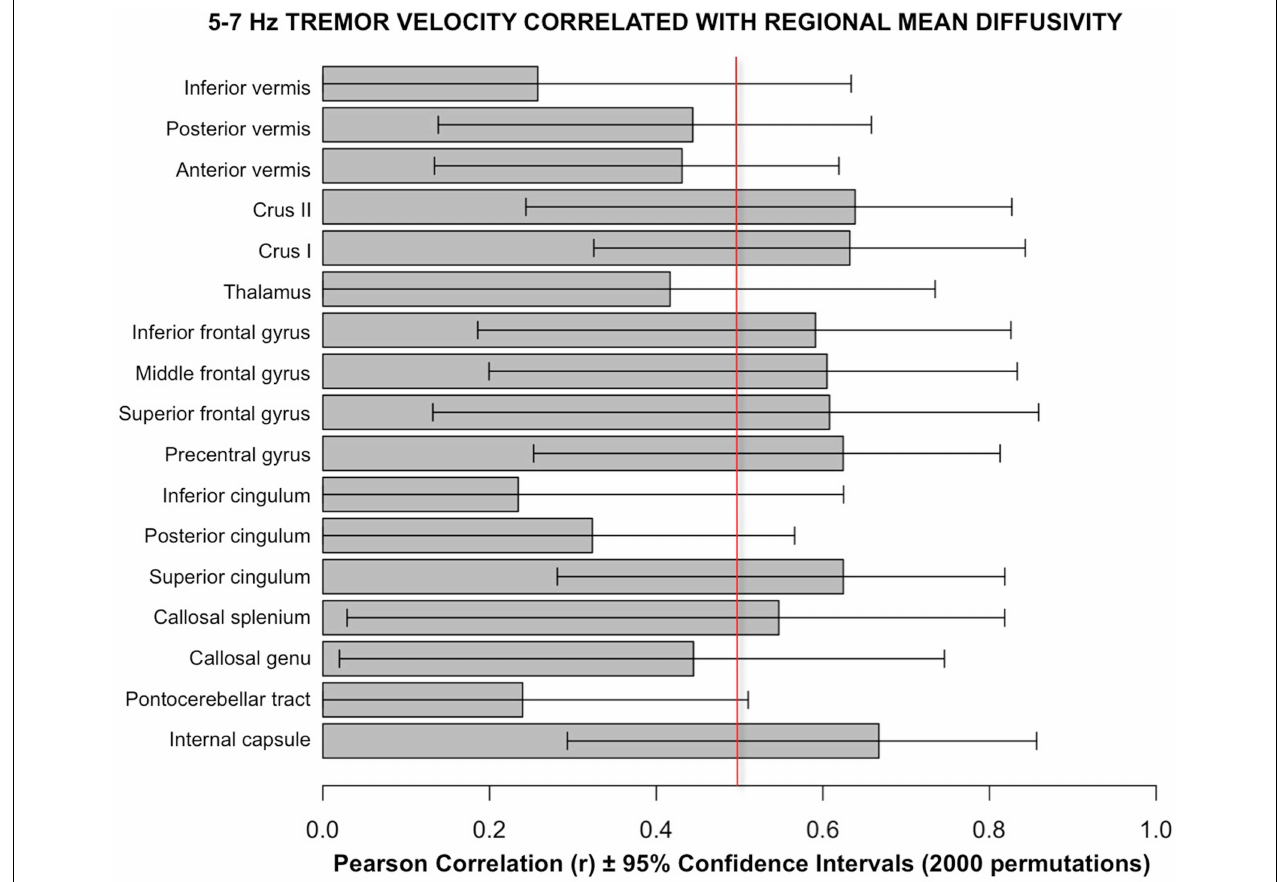
2000 permutations. The vertical red line marks the approximate level of correlation required to achieve statistical significance after correction for multiple